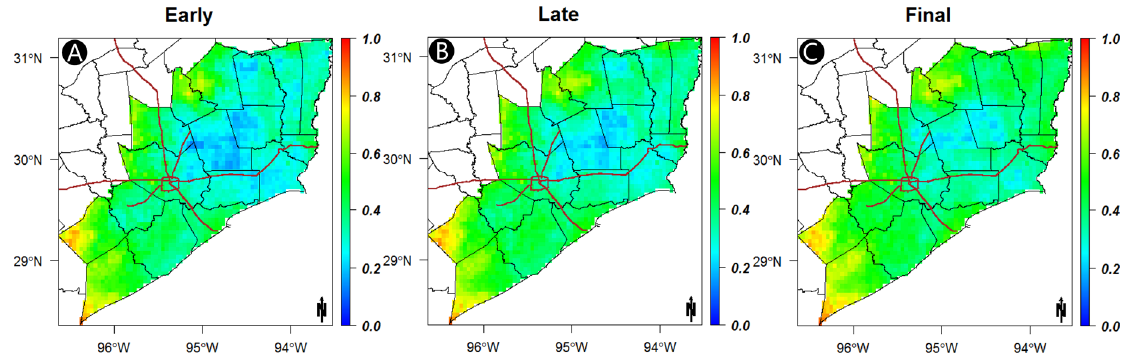
Figure 11. Spatial distribution of FAR for the IMERG ( A ) Early-, ( B ) Late-, and ( C ) Final-run products during Tropical Storm Imelda.